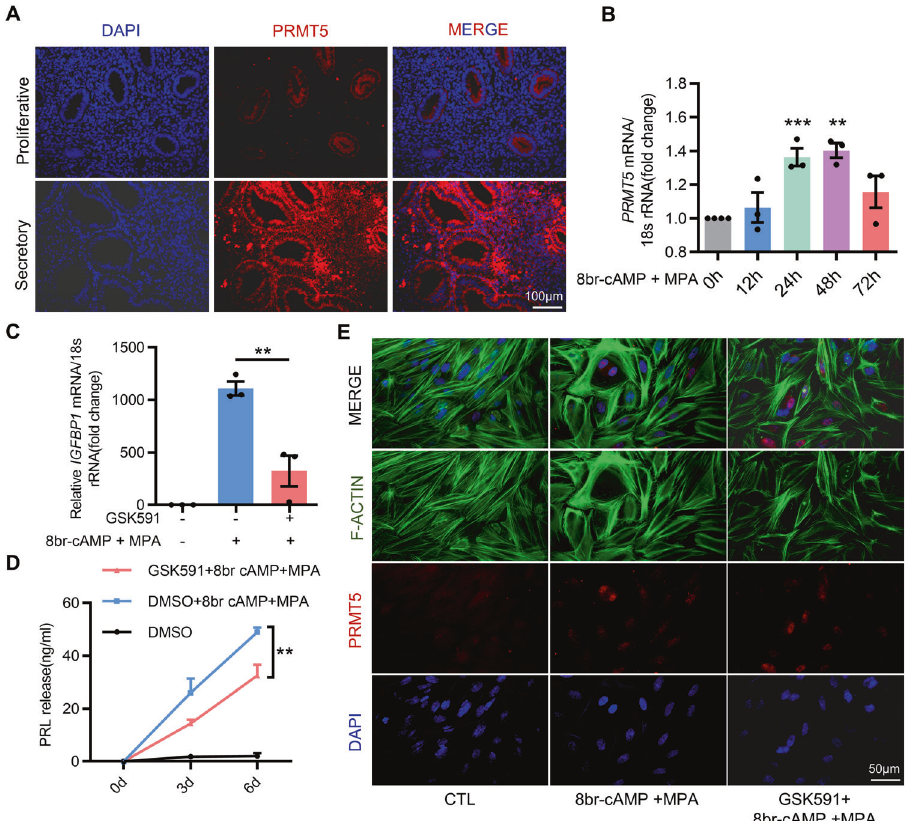
Fig. 4 PRMT5 activity ensures human endometrial stromal cell decidualization. A Immuno fl uorescence staining of PRMT5 proteins in the proliferative and secretory phase endometria, scale bar = 100 µm. B qRT – PCR analysis of PRMT5 mRNA in human endometrial stromal cells (hEnSCs) treated with medroxyprogesterone acetate (MPA) and 8Br-cAMP for 0, 12, 24, 48 and 72 h. C qRT – PCR analysis of IGFBP1 mRNA in hEnSCs treated with or without the PRMT5 inhibitor GSK591 for 24 h before 3 days of treatment with 8Br-cAMP and MPA. D ELISA of PRL levels in supernatant obtained from hEnSCs decidualized for 3 and 6 days with or without the PRMT5 inhibitor GSK591. E Immuno fl uorescence staining for F-actin in hEnSCs treated with or without the PRMT5 inhibitor GSK591 before 3 days of treatment with 8Br-cAMP and MPA, scale bar = 50 µm. Means ± SEM. ** P < 0.01, *** P < 0.001, One-way ANOVA with Tukey ’ s multiple comparisons test in B , Student ’ s t -test in C , Two-way ANOVA with Tukey ’ s correction for multiple comparisons in D